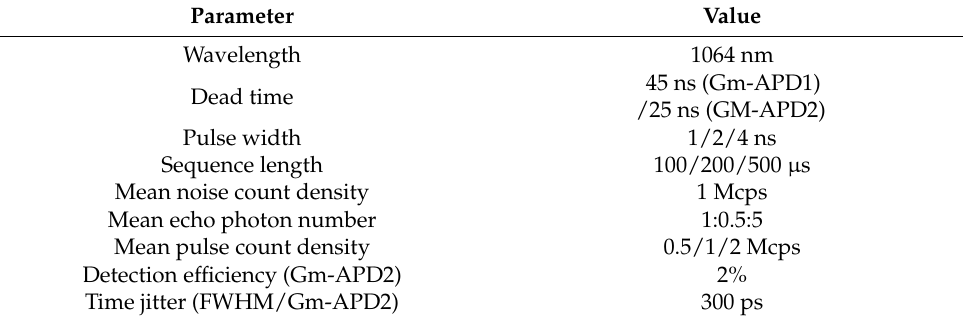
Figure 9. ( a ) True random coding photon counting lidar experimental platform. ( b ) IRF signal detections with Gaussian curve fitting, where estimated Gaussian RMS width is 0.464 ns, thus FWHM is 1.09 ns. Table 4. System parameters for true random coding photon counting